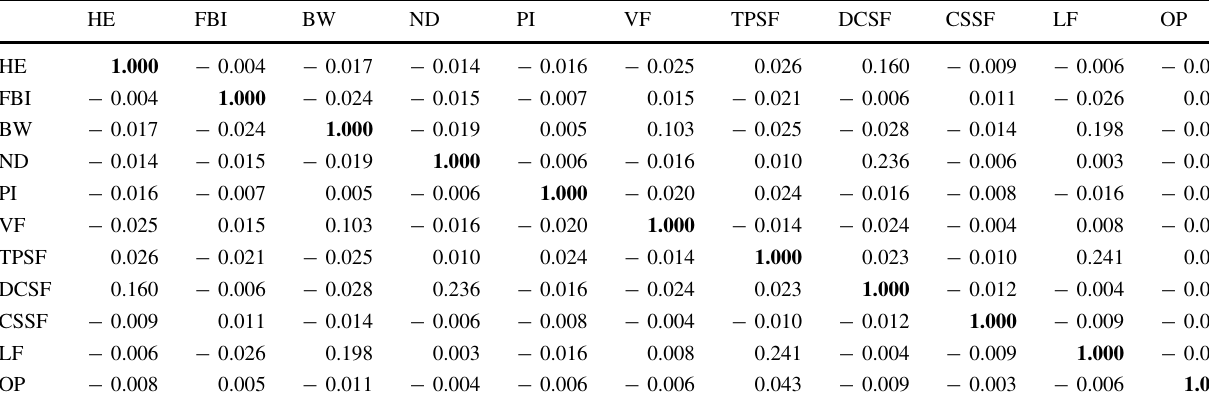
Table 2 Correlation matrix between various factor